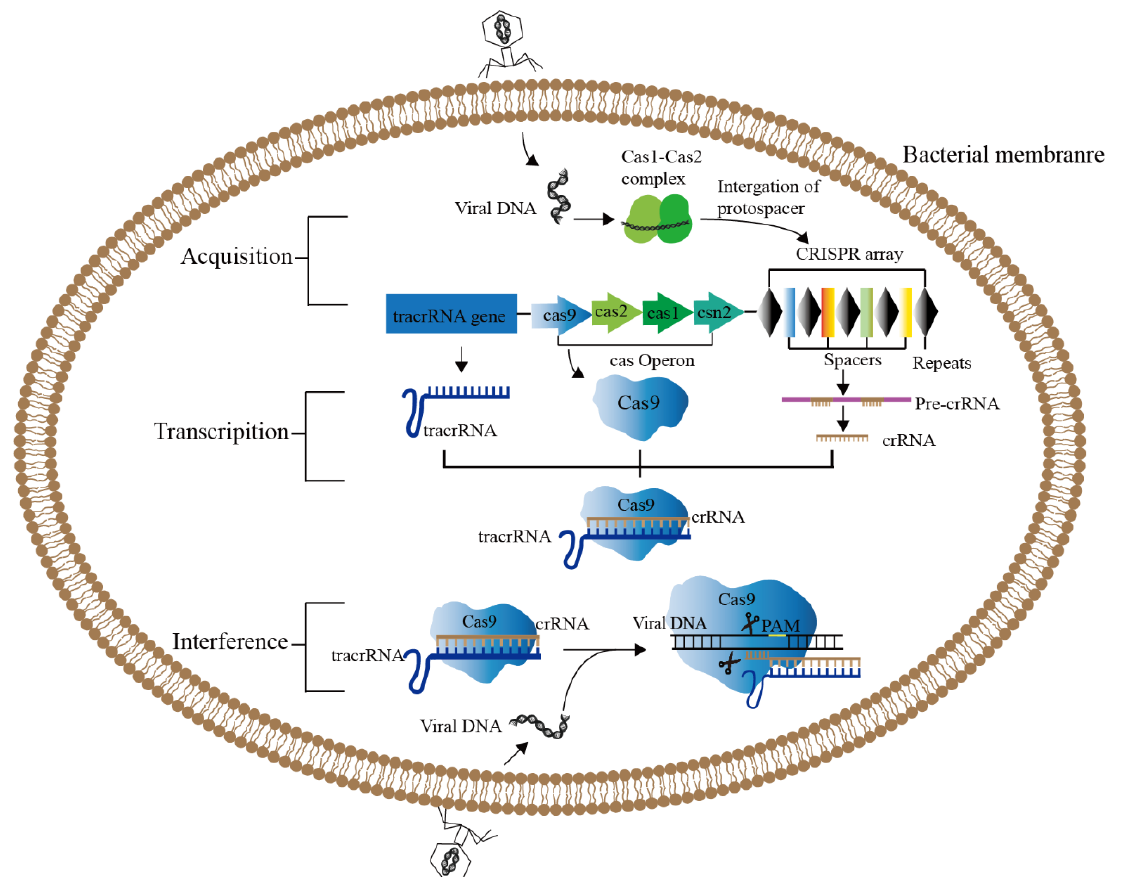
Figure 1. CRISPR/Cas9 system in bacterial adaptive immunity. The functional driving of CRISPR/Cas9 system is divided into three stages. Acquisition: After phage infection, the Cas1-Cas2 protein complex will scan the invading DNA and identify the PAM region, and integrate the new spacer into the CRISPR sequence through the collection mechanism (cas1, cas2, csn2). Transcription: CRISPR sequence is transcribed to produce pre-crRNA under the control of the leading region, and tracrRNA is also transcribed. Pre-crRNA is further processed to form mature crRNA, which forms double-stranded RNA with tracrRNA through base complementary pairing. (3) Interference: The crRNA-tracrRNA duplex binds to Cas9 and guides Cas9 to cleave foreign DNA containing a 20-nt crRNA complementary sequence preceding